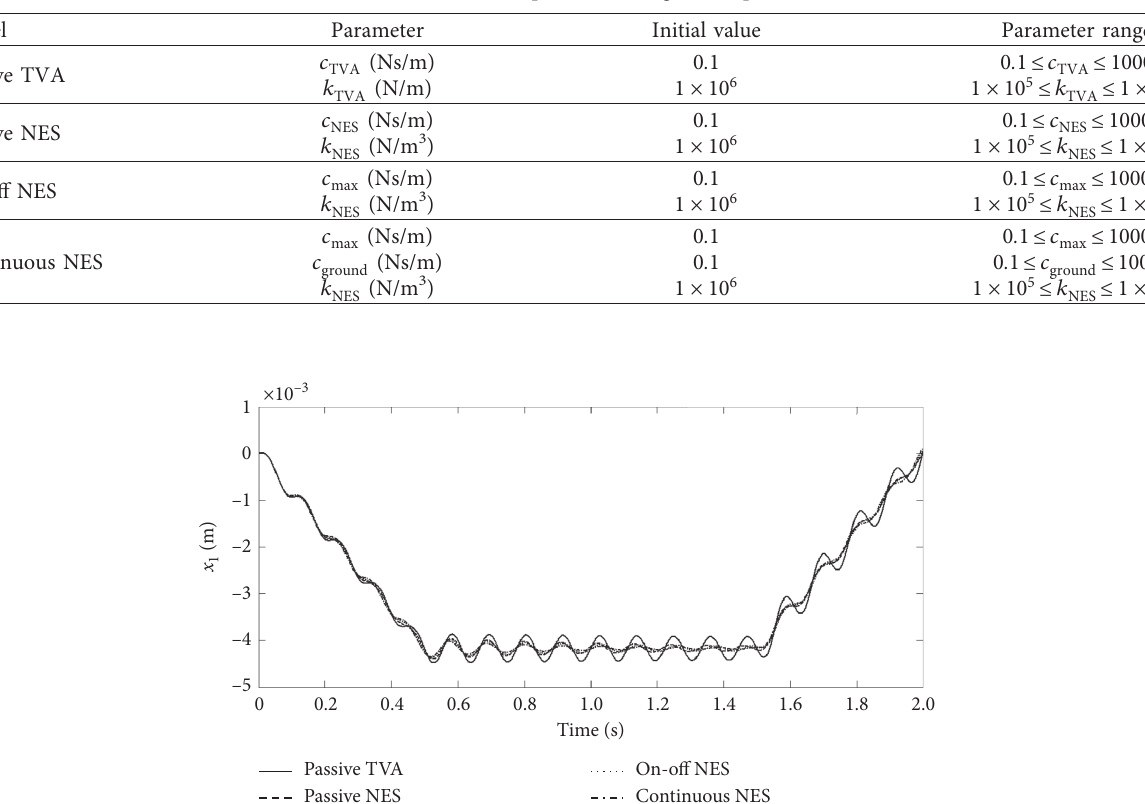
Table 2: Initial values and parameter ranges for optimization.